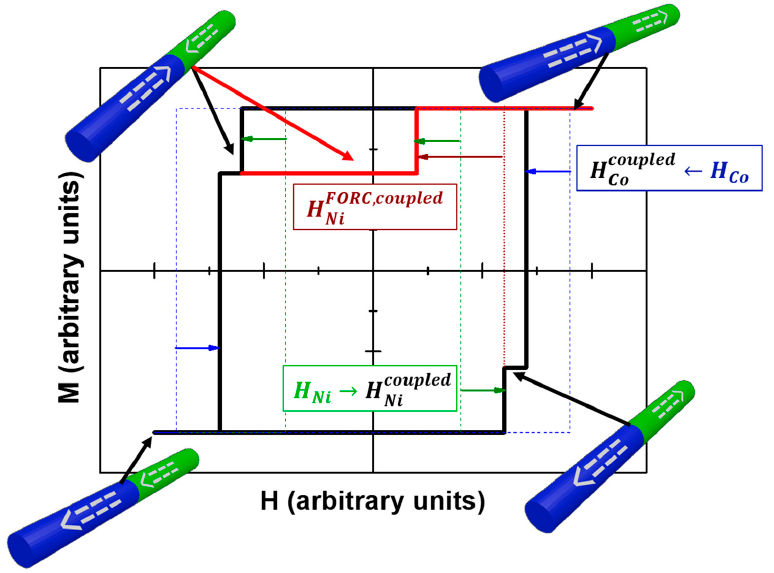
Figure 2. Schematic representation of the two-step magnetization reversal hysteresis loop of a bisegmented Ni(green)/Co(blue) nanowire. Dashed lines denote the intrinsic hysteresis loops for Ni and Co segments. The arrows indicate the change on the switching fields with respect their intrinsic values due to the magnetic coupling between the Co and Ni segments. Red line indicates the expected behavior of a first order reversal curve starting from the antiparallel configuration.